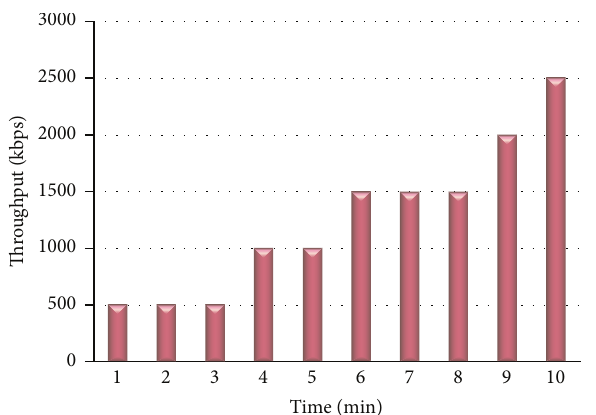
Figure 8: Fluctuation curve of peer throughput.